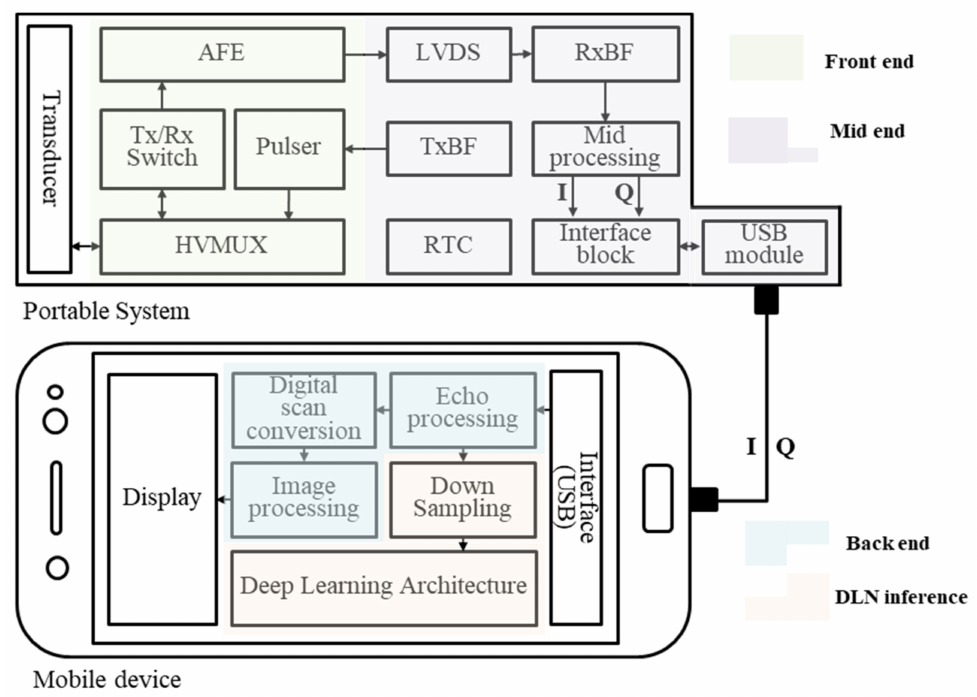
Figure 6. Overall block diagram of the mobile device-based portable ultrasound system for simultaneous ultrasound signal processing and deep learning network (DLN) inference.